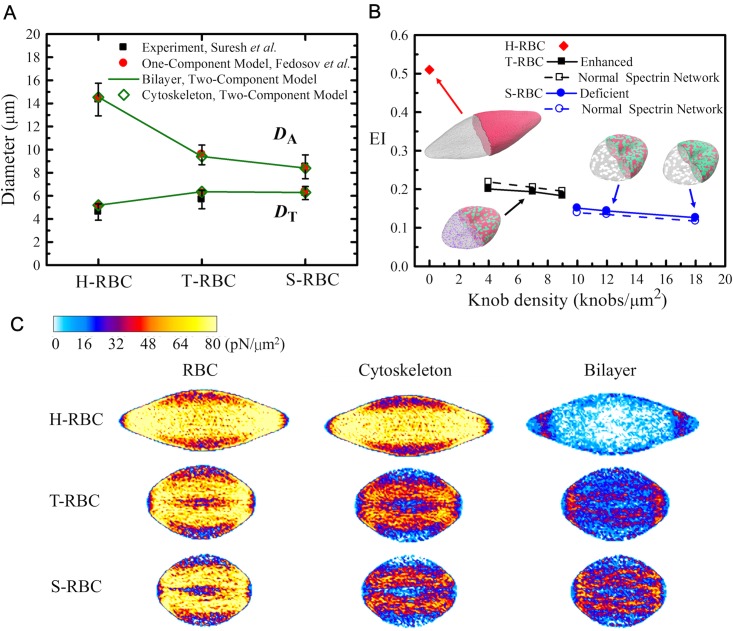
Shape deformation and corresponding stress field of H-RBCs, T-RBCs and S-RBCs.(A) The axial (DA) and transverse (DT) diameters of H-RBC, T-RBC, and S-RBC at stretching force Fs = 110 pN. For comparison, the stretching responses in experiments from Ref. [2] and one-component whole-cell model from Ref. [24] are shown. (B) Functional dependence of EI values of T-RBCs and S-RBCs on knob density at stretching force Fs = 110 pN. (C) Corresponding stress contours of stretched H-RBC, T-RBC (ρknob,DPD≈ 7 knobs/μm2), and S-RBC (ρknob,DPD≈ 12 knobs/μm2).